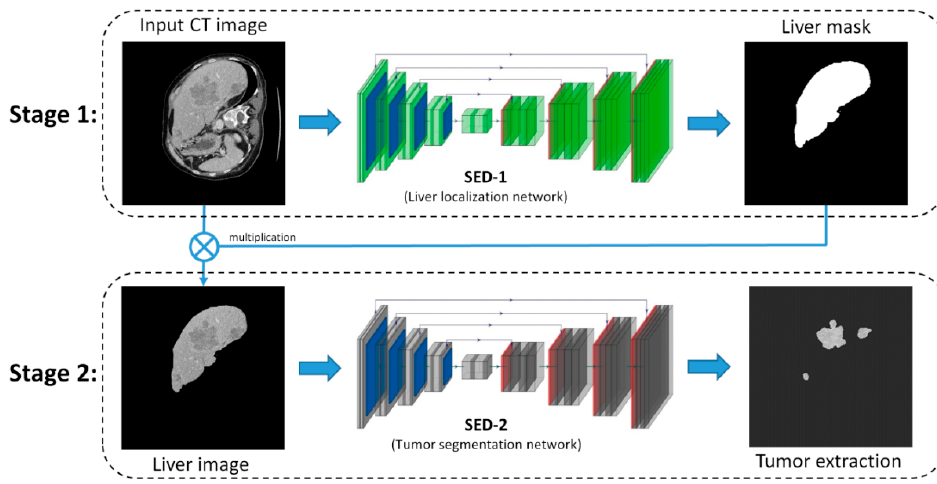
Figure 1. Overview of the proposed Successive Encoder-Decoder (SED) method.